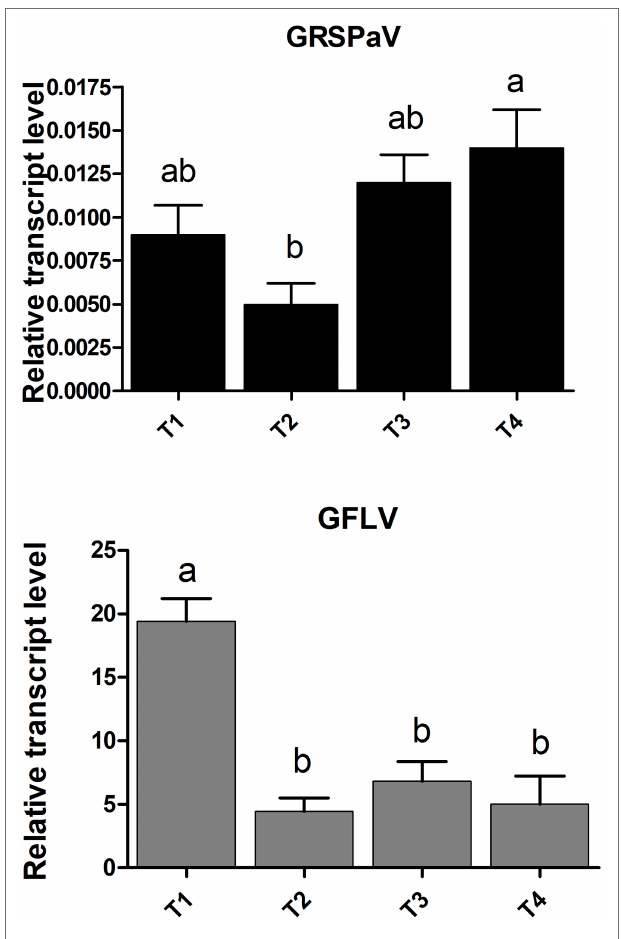
FIGURE 1 | Relative accumulation of grapevine rupestris stem pitting- associated virus (GRSPaV) and grapevine fan leaf virus (GFLV) in grapevine cv. Chardonnay leaf tissue, at different times (T1 to T4, at monthly intervals) during the vegetative season. Quantitative reverse transcription-PCR (RT- qPCR) signals were normalized to VvAct and VvUBI transcripts. Data are presented as the mean ± SE ( n = 4). Lowercase letters denote significant differences attested by Tukey’s honestly significant difference (HSD) test ( p <